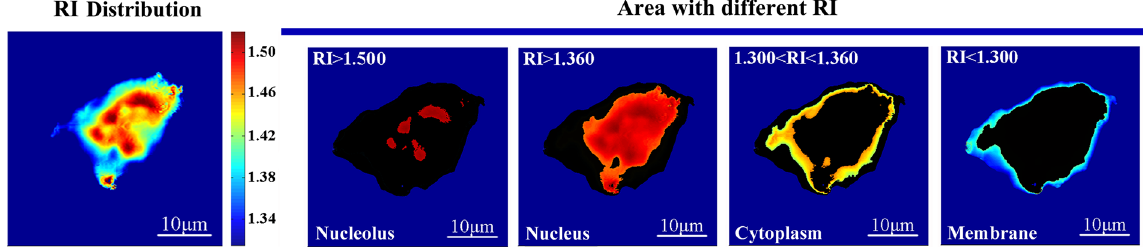
Figure 4. Refractive index distribution of single Jurkat cell, in which the refractive index distribution was coded with pseudocolor, the areas of RI > 1.360 were marked as nucleus, specially, RI > 1.500 corresponding to nucleolus; the areas of 1.360 > RI > 1.300 and RI < 1.300 were respectively marked as cytoplasm and membrane.